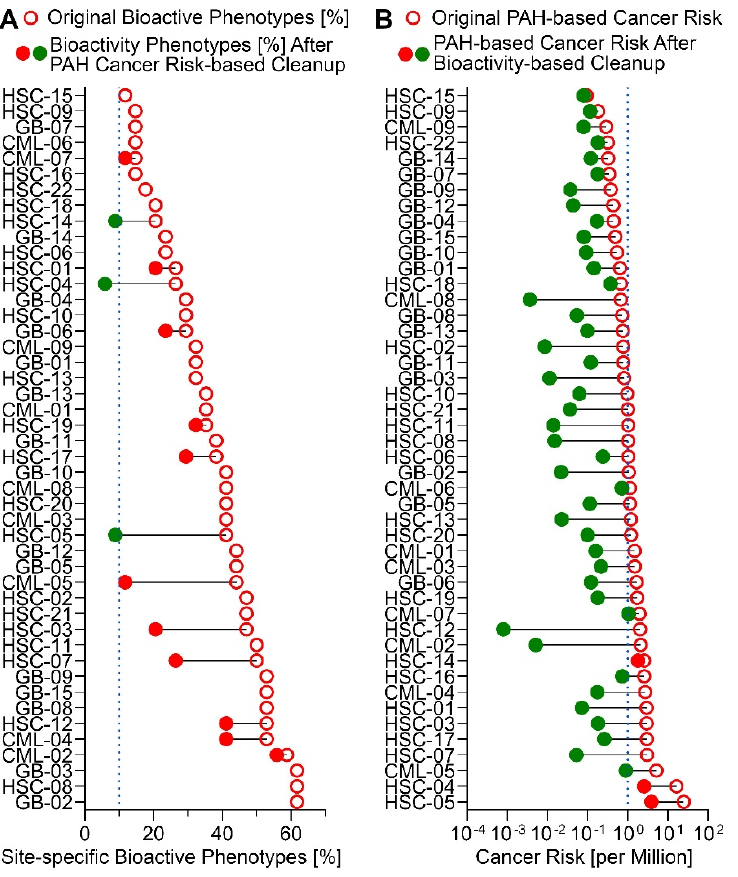
Figure 6. Risk Characterization at Baseline and Under Traditional and Bioactivity-based Remediation Goals. Shown are bioactivity ( A ) and cancer risk due to PAHs ( B ) at baseline (open red circles on the right of each dumbbell) and after traditional chemical-based ( A ) or bioactivity-based ( B ) remediation (closed circle on left of each dumbbell; green if below the remediation goal, red if still above the remediation target). The dotted lines represent the “target” remediation criteria (10% phenotypes active for bioactivity and “1 in a million” cancer risk for PAHs). Panel A shows that cleanup based on reducing traditional cancer risks is not protective with respect to remaining bioactivity, and results in substantial residual bioactivity across in vitro phenotypes. Panel B shows that cleanup based on reducing bioactivity is also protective of cancer risks for PAHs, reducing contamination in all but three sites to the residual risk values of <1 in a